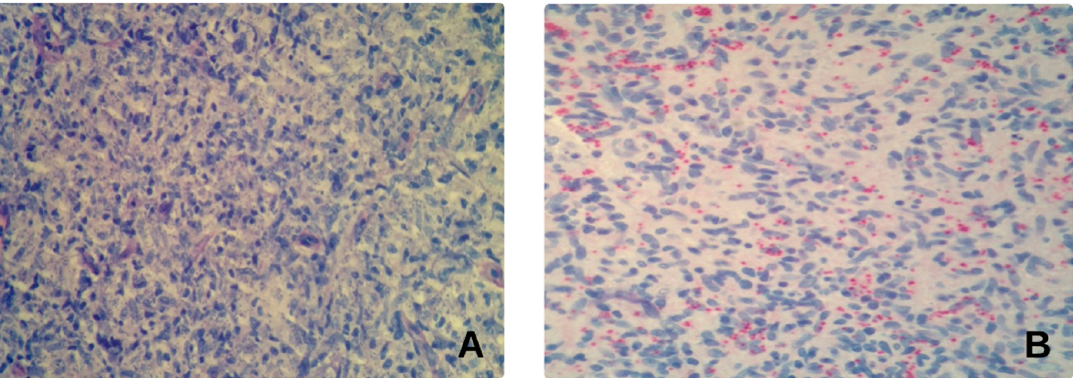
Figure 2. Histologic examination of ML bioptic specimen (Case 1). ( A ) Giemsa staining revealing a non-necrotizing granulomatous inflammatory infiltration, rich in plasma cells and epithelioid histiocytes containing eukaryotic elements, suspected for Leishmania . ( B ) Immunohistochemistry staining with CD1a confirmed an intense positivity for CD1a of Leishmania amastigotes in parasitized macrophages and in extracellular space.